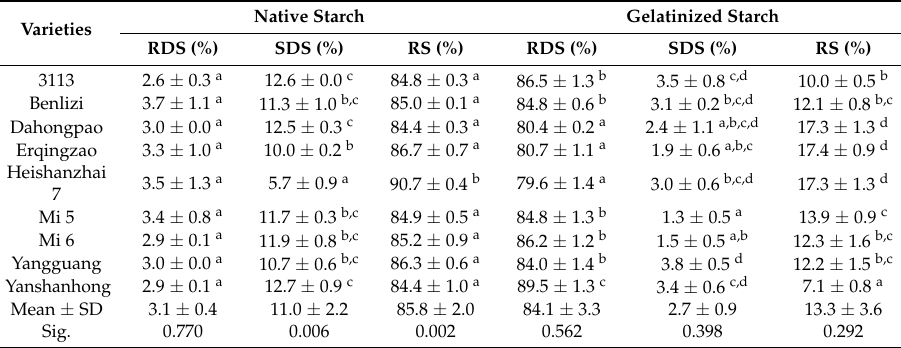
Table 6. Digestion properties of